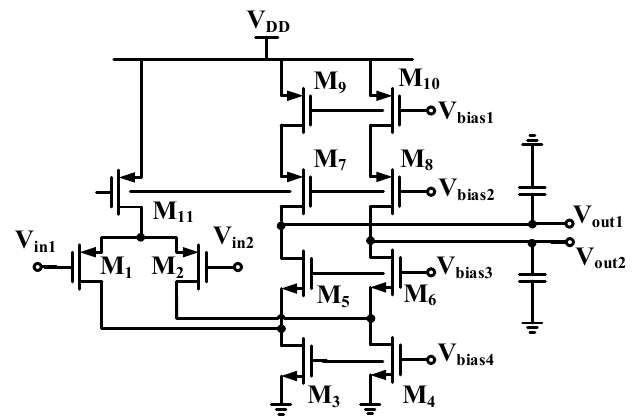
Figure 5. The folded cascade amplifier circuit.